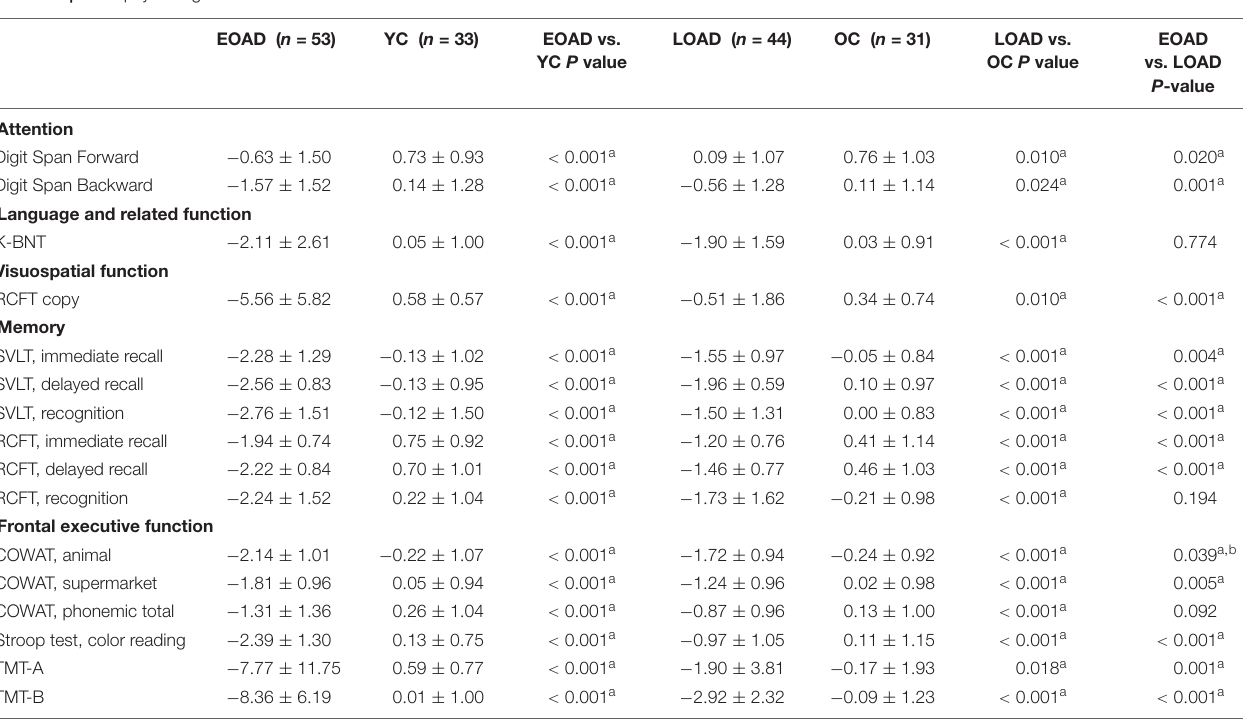
TABLE 2 | Neuropsychological test